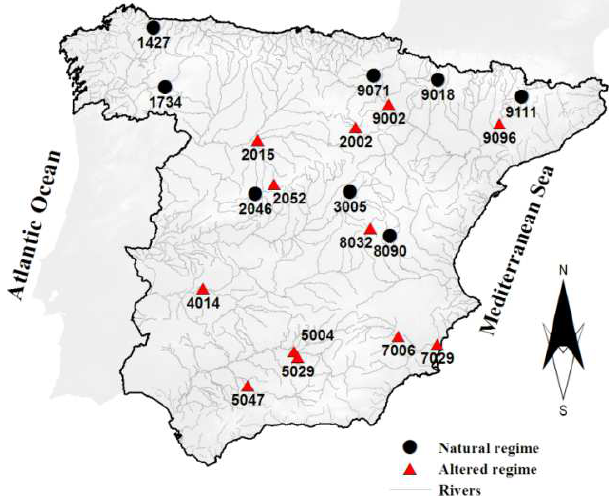
Figure 1. Spatial distribution of the selected 20 flow gauge stations in continental Spain. Circles indicate natural regime and triangles altered